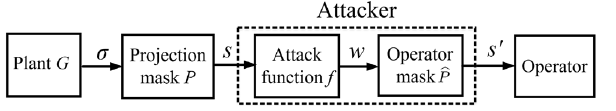
Figure 1. A plant G under